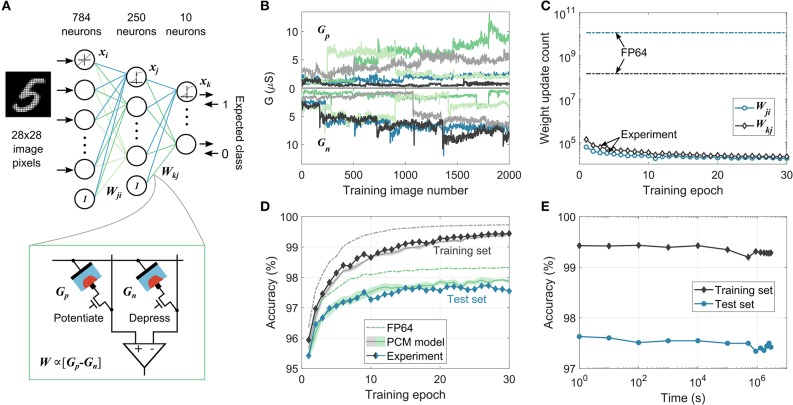
MCA training experiment using on-chip PCM devices for handwritten digit classification. (A) Network structure used for the on-chip mixed-precision training experiment for MNIST data classification. Each weight, W, in the network is realized as the difference in conductance values of two PCM devices, Gp and Gn. (B) Stochastic conductance evolution during training of Gp and Gn values corresponding to 5 arbitrarily chosen synaptic weights from the second layer. Each color corresponds to a different synaptic weight. (C) The number of device updates per epoch from the two weight layers in mixed-precision training experiment and high-precision software training (FP64), showing the highly sparse nature of weight update in MCA. (D) Classification accuracies on the training (dark-shaded curves) and test (blue-shaded curves) set from the mixed-precision training experiment. The maximum experimental test set accuracy, 97.73%, is within 0.57% of that obtained in the FP64 training. The experimental behavior is closely matched by the training simulation using the PCM model. The shaded areas in the PCM model curves represent one standard deviation over 5 training simulations. (E) Inference performed using the trained PCM weights on-chip on the training and test dataset as a function of time elapsed after training showing negligible accuracy drop over a period of 1 month.